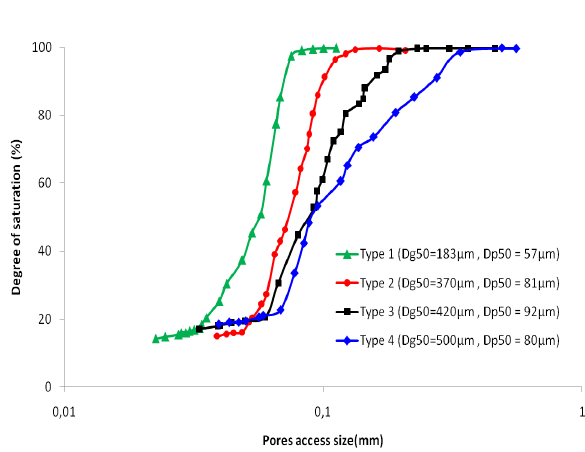
Figure 16: Effect of sand density index on pore-access size distribution.